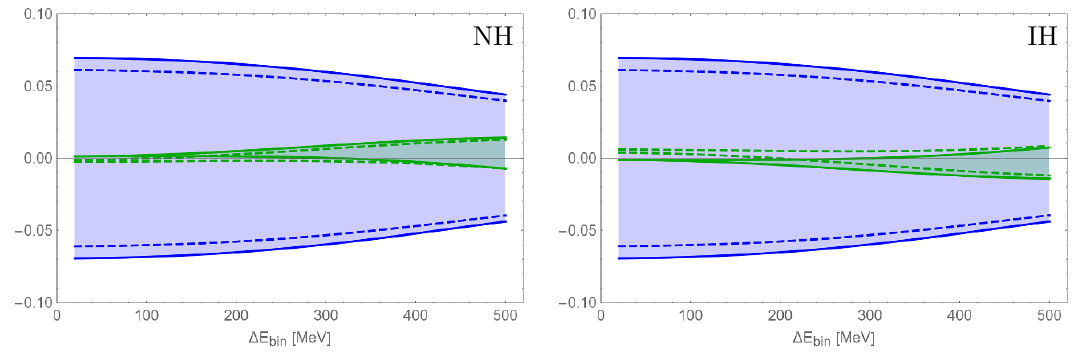
Figure 10 . Average value of the CPT-odd (green) and T-odd (blue) compoments of A CP DUNE baseline L = 1300 km, in an energy bin width (cid:1) E bin centered on the magic energy (6.8). Both the exact (dashed) and the analytical (solid) results from eqs. (3.25) are shown. Nor- mal/Inverted Hierarchy in the left/right pannel. The bands correspond to all possible values changing (cid:14) in (0 ; 2 (cid:25) ); the upper/lower lines for A CPT